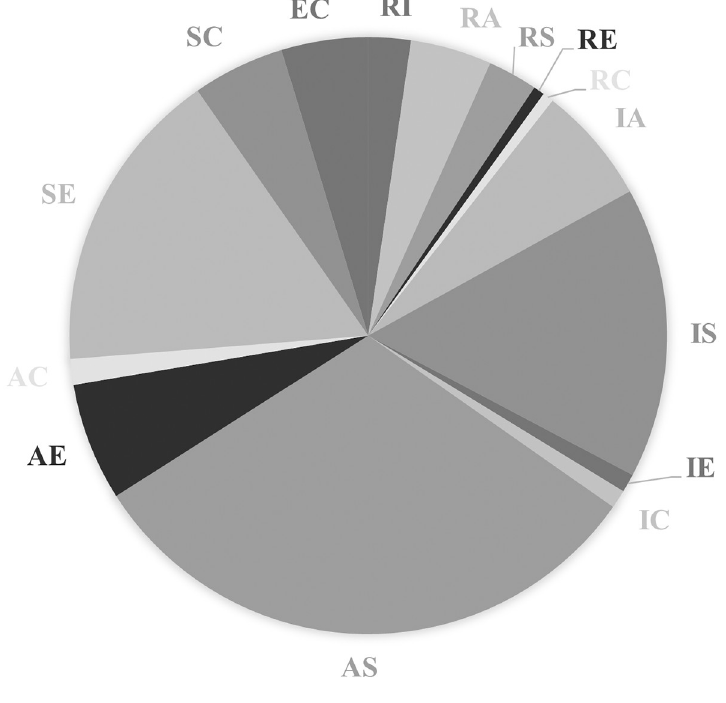
Fig 5. Distribution of two-dimensional interest types among young women. Note: The figure is visually simplified by including one combination of letter orderings. For instance, RI includes individuals whose primary interests were ranked R and then I, as well as those who ranked I and then